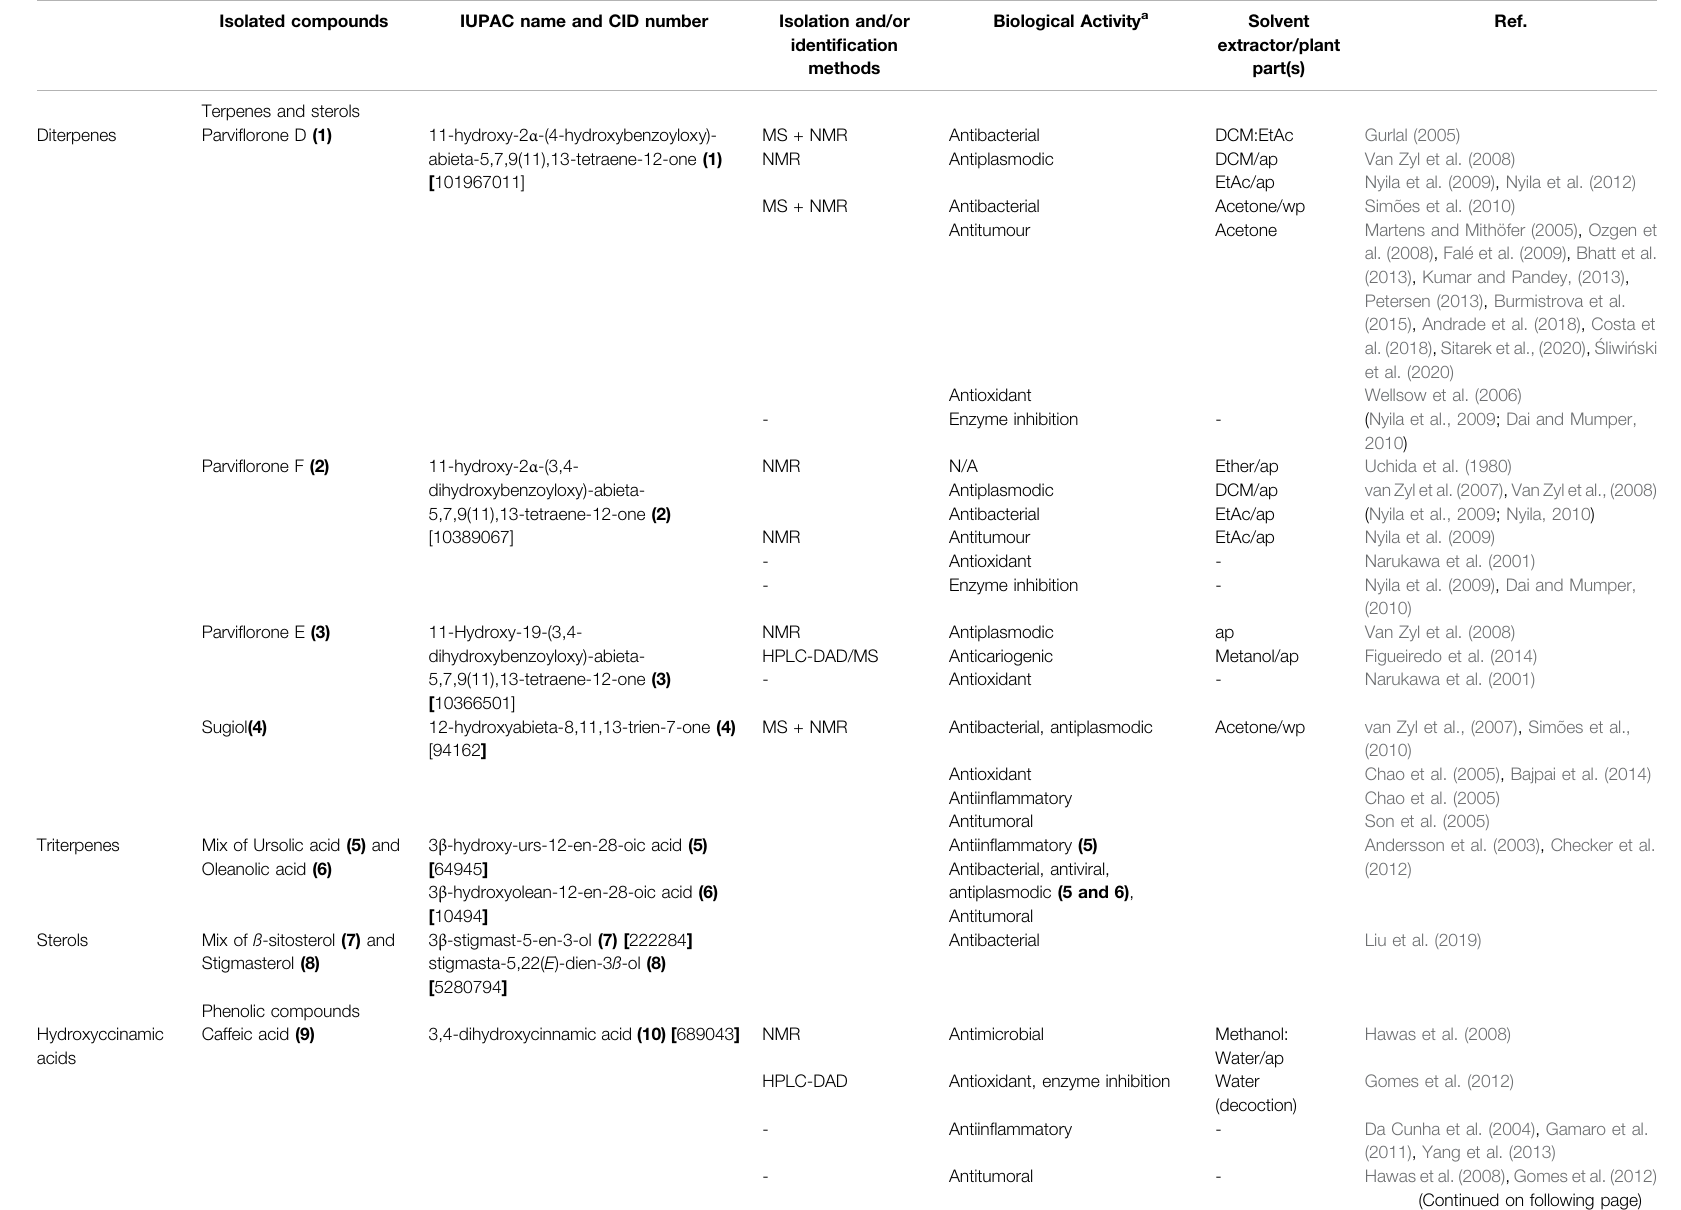
TABLE 1 | The compounds isolated to date from P. ecklonii